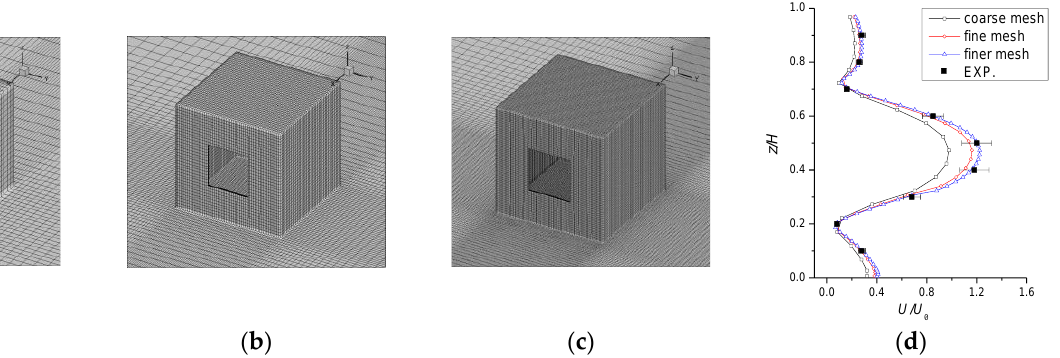
Figure 3. Mesh generation and grid independence analysis. ( a ) coarse mesh; ( b ) fine mesh; ( c ) finer mesh and ( d ) grid independence analysis. Table 2. The boundary conditions for the numerical models.